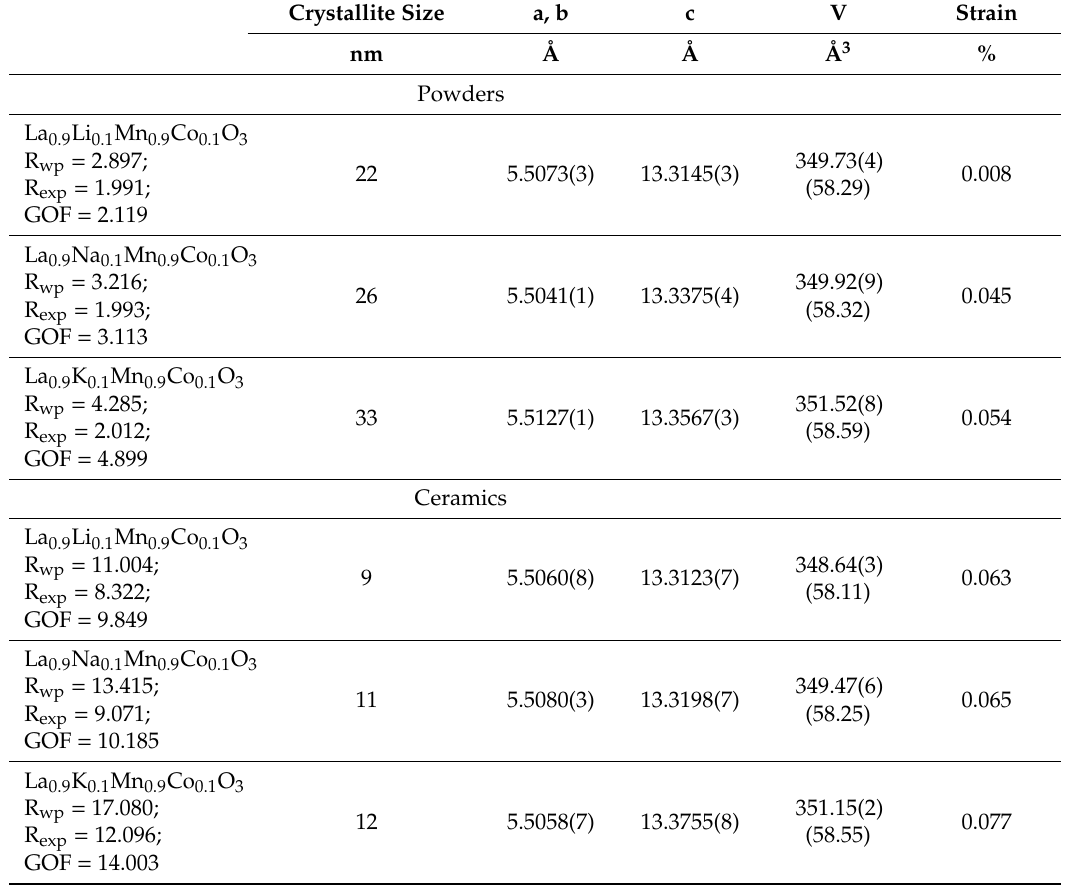
Table 1. Average crystallite size and the cell parameters calculated for La 0.9 A 0.1 Mn 0.9 M 0.1 O 3 powders and ceramics based on the XRD